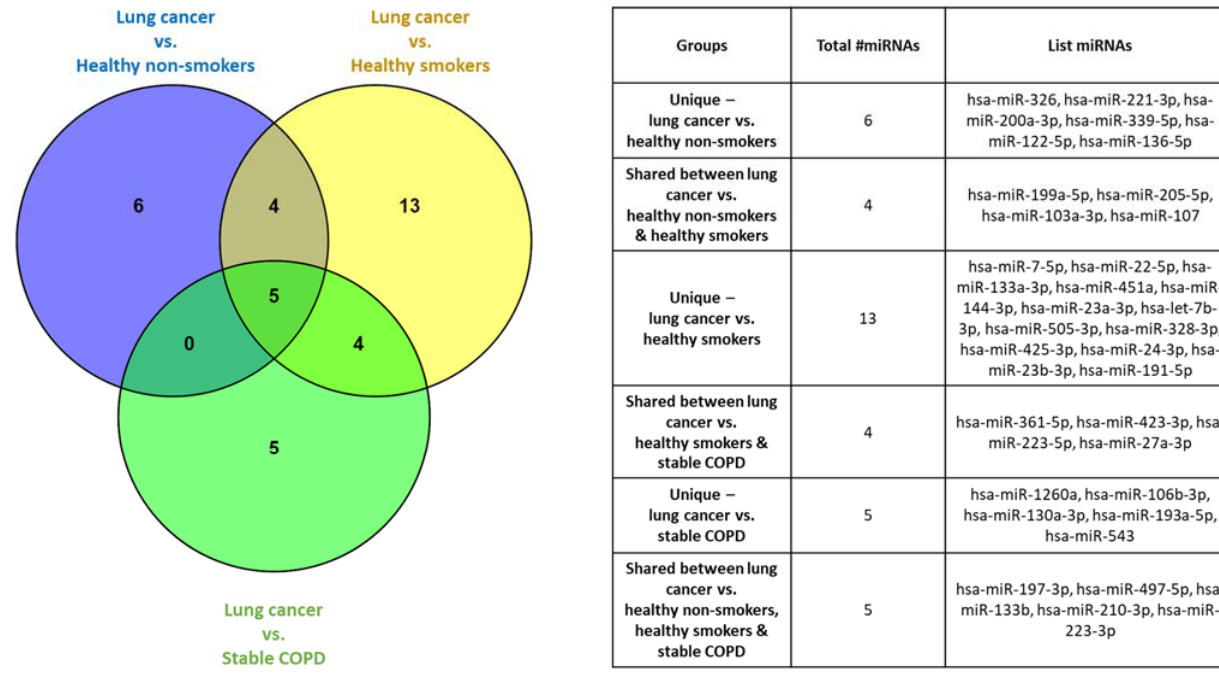
Figure 3. Venn diagram listing the dysregulated miRNAs unique and common for lung cancer participants and comparator groups including healthy non ‐ smokers, healthy smokers, and stable COPD participants. Venn diagram created using Venny 2.1 software [23] .